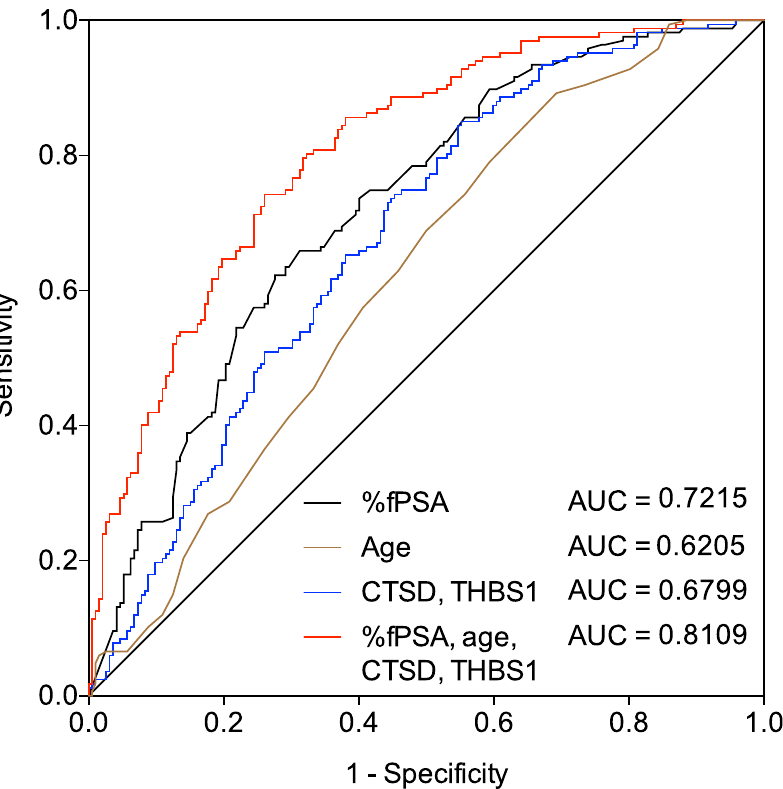
Fig 4. Receiveroperating characteristics (ROC) analysis of different models. ROC curves depictingthe accuracyin predictingPCa in 359 men who had PSA levels of 2–10 ng/ml (192 PCa negative and 167 PCa positive cases). ROC curves highlightbenefits of the CTSD and THBS1 alone (blue line), %fPSA (black line), age (brownline) and the combination of %fPSA, age, CTSD and THBS1 (red line).